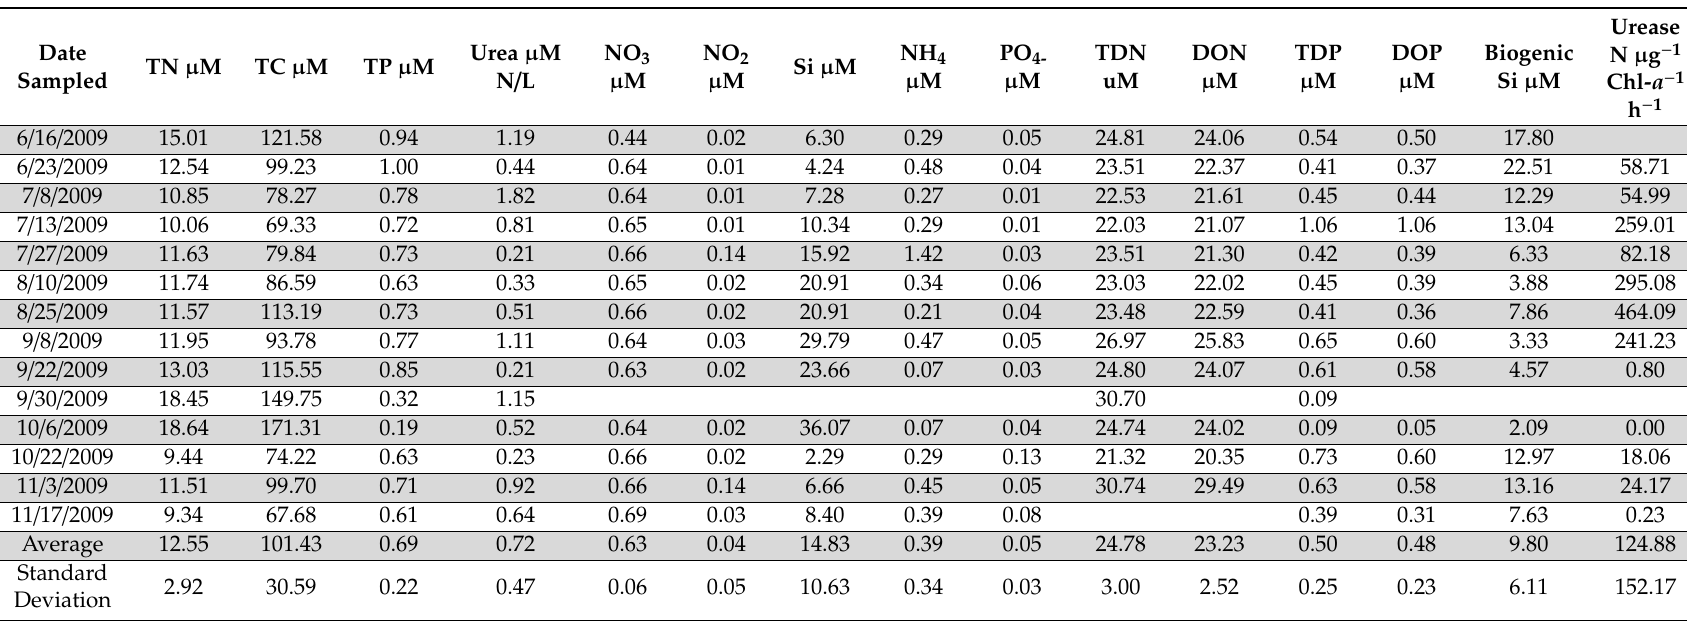
Table 2. Analysis of nutrients from discrete water samples collected from the MARVIN site (Station 3) during the 2009 deployment in Sarasota Bay. Missing data for 30 September were due to equipment